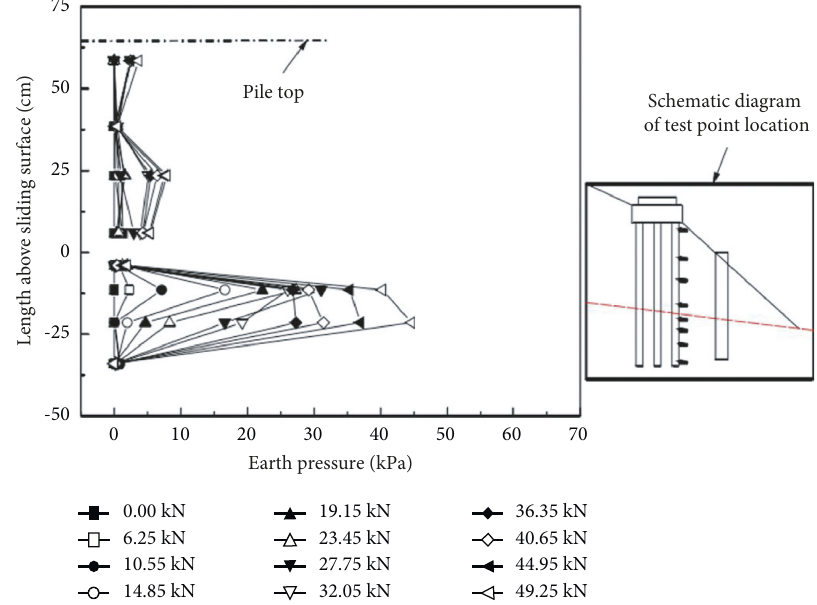
Figure 21: Relationship between soil pressure distribution and load in front of bridge foundation pile.